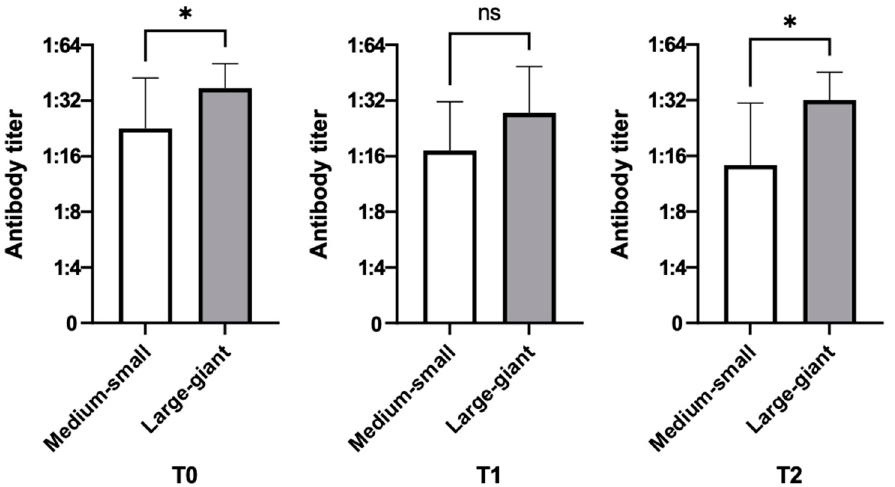
Figure 3. Antibody titers toward infectious hepatitis at different timepoints according to dog size (small/medium, n = 12; large/giant, n = 9). Statistically significant differences are indicated with *, and “ns” represents no statistical significant results.